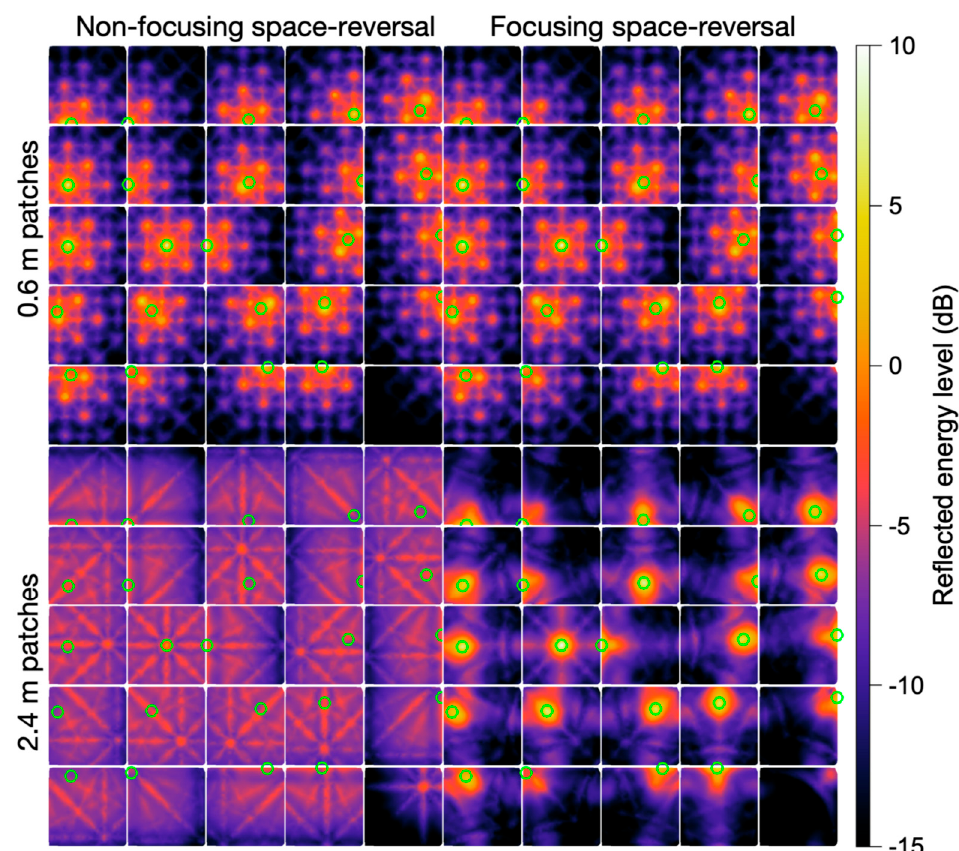
Figure 8. Spatial distribution of reflected energy level over a 2.4 × 2.4 m square for 25 source positions 2 m from the 7.2 × 7.2 m reflector, with space-reversal patches. Small (0.6 m) and large (2.4 m) patch sizes are shown, for non-focusing and focusing space-reversal patches. Source locations are indicated by the green circles (the source for the bottom left subplot of each quadrant is outside of the receiver square). Values are speech-A-weighted.